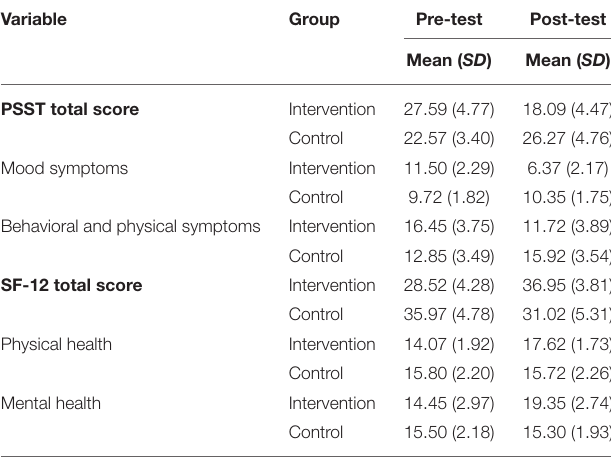
TABLE 4 | The comparison of age between control and intervention groups. Variable